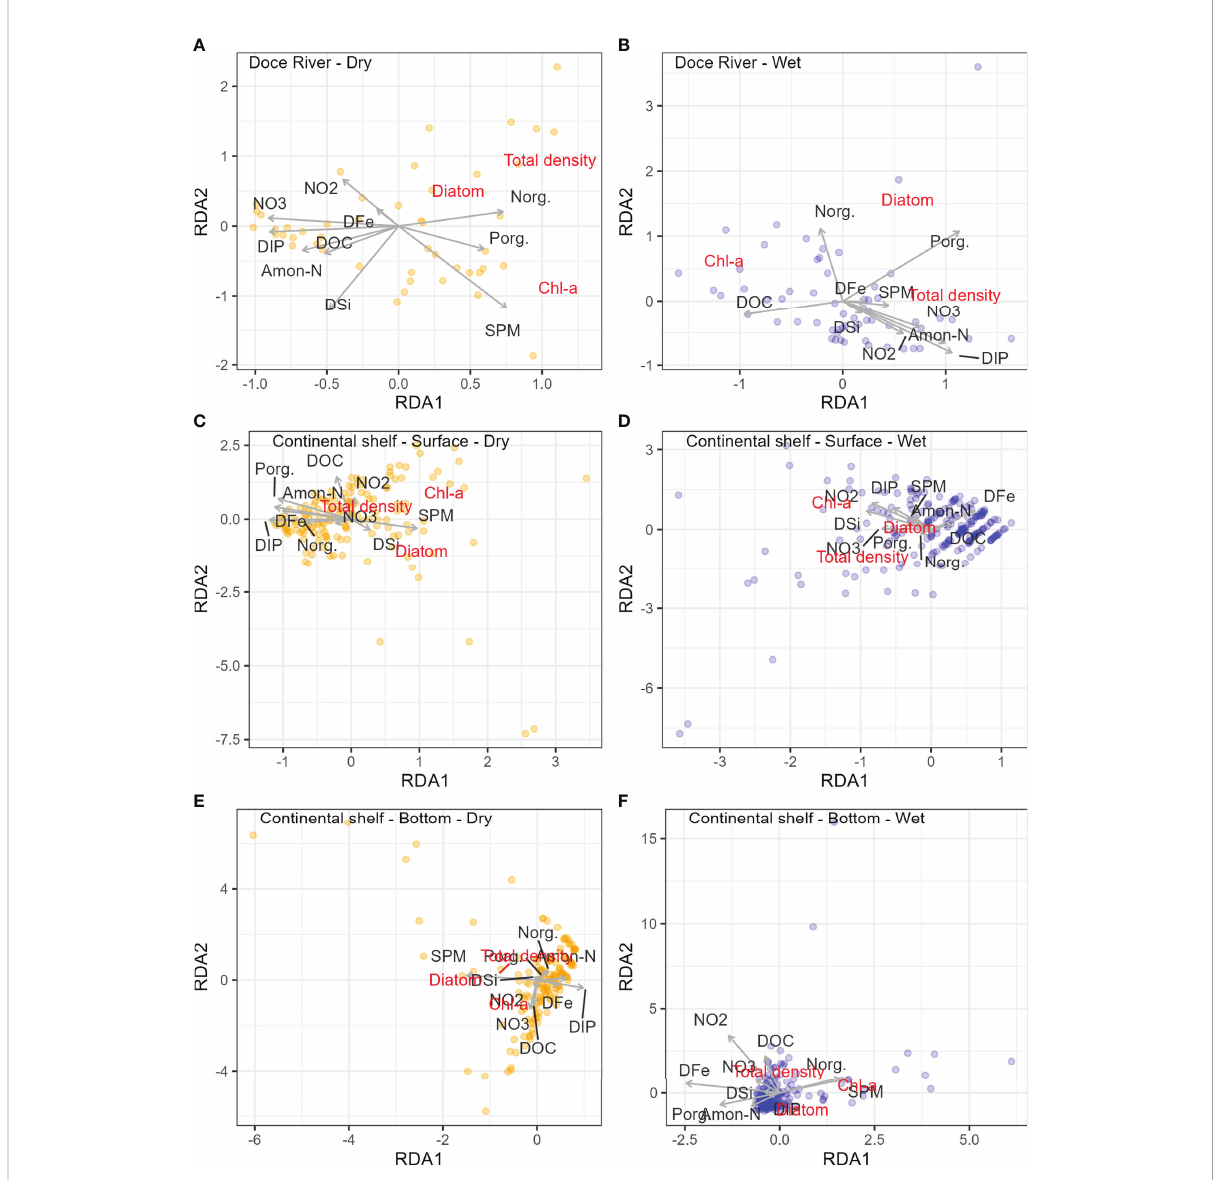
FIGURE 5 Redundancy analysis (RDA) of dissolved inorganic phosphate (DIP), total organic phosphorus (Porg), nitrite ( NO − 2 ), nitrate ( NO − 3 ), ammoniacal nitrogen (Amon-N), organic nitrogen (Norg), dissolved silicate (DSi), suspended particulate matter (SPM), dissolved organic carbon (COD), as explanatory variables, and chlorophyll a (Chl-a), diatom density (Diatom) and total phytoplankton density (Total density), as the response variable, for the river channel ( A : Dry season; B : Wet season) and continental shelf ( C : Surface – Dry season; D : Surface – Wet Season; E : Bottom – Dry Season; F : Bottom – Wet